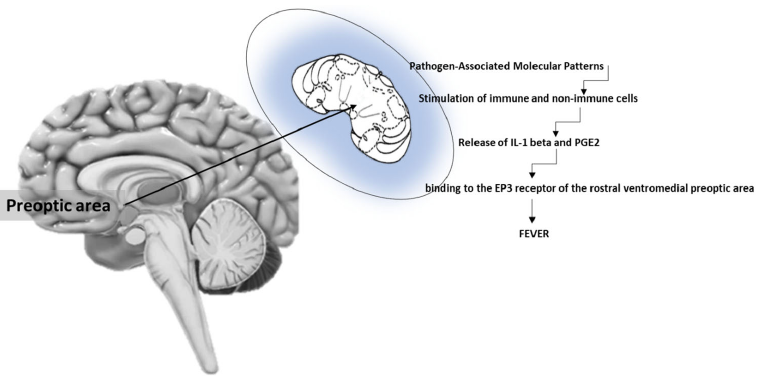
Figure 1. Major mechanisms of fever at the brain level. The preoptic area is endowed with PGE2 receptors (mostly EP3), whose stimulation generates fever. receptors (mostly EP3), whose stimulation generates